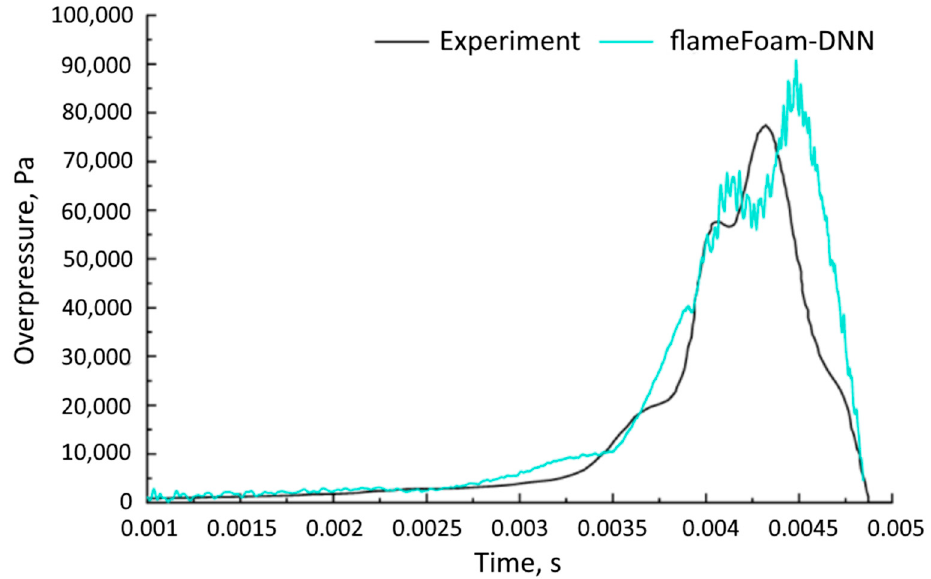
Figure 13. Numerical and experimental [54] overpressure evolution.